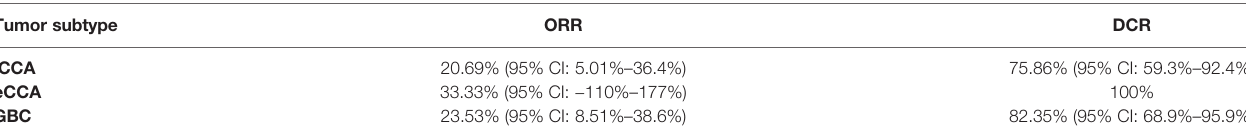
TABLE 3 | Objective response rate/Disease control rate. Tumor subtype